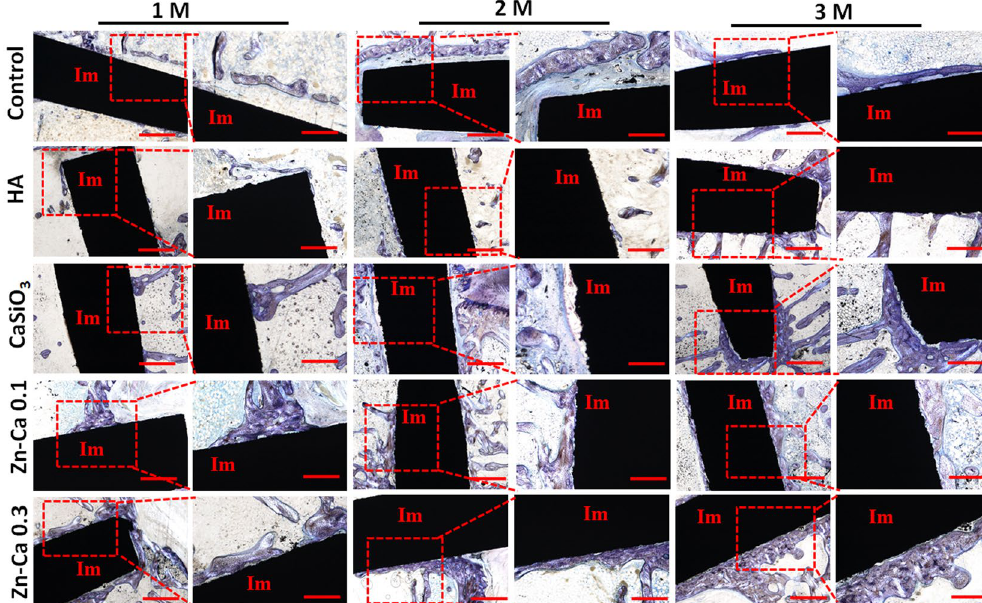
Figure 6. Histological, toluidine blue-stained sections from osteoporotic rabbits 1, 2, 3 months post- implantation for Ti-6Al-4V and the hydroxyapatite (HA), CaSiO 3 , Zn-Ca 0.1 and Zn-Ca 0.3 coatings. Right panel (Scale bar indicates 500 μ m): magnification of the left red square in panel (Scale bar indicates 1000 μ m) in each month. Im, implant; M,